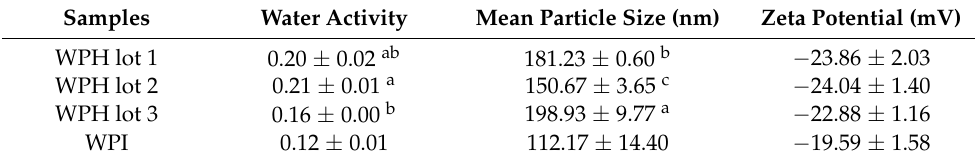
Table 2. Water activity, mean particle size, and zeta potential of WPH and WPI sample.